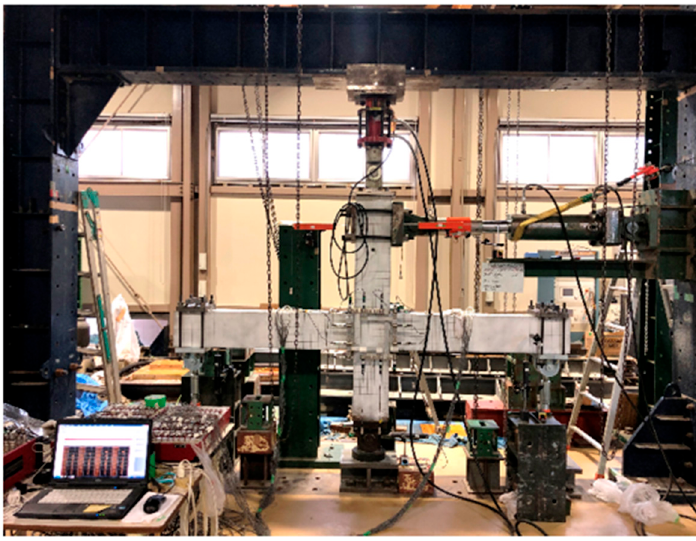
Figure 4. Photograph of the test setup.